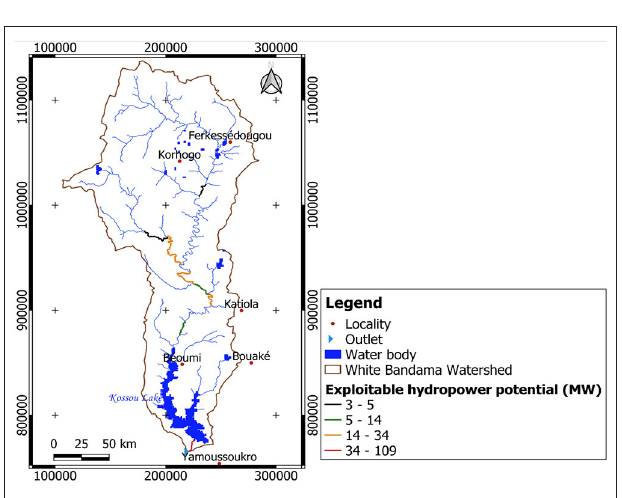
FIGURE 11 | Assessment of the exploitable hydropower potential of the